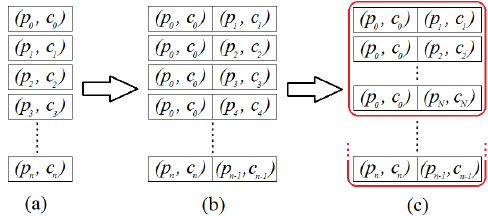
Figure 1: New Differential Secret-Key Distinguishers for round-reduced AES . Consider N (plaintext, ciphertext) pairs (a). In a “classical" differential attack (b), one